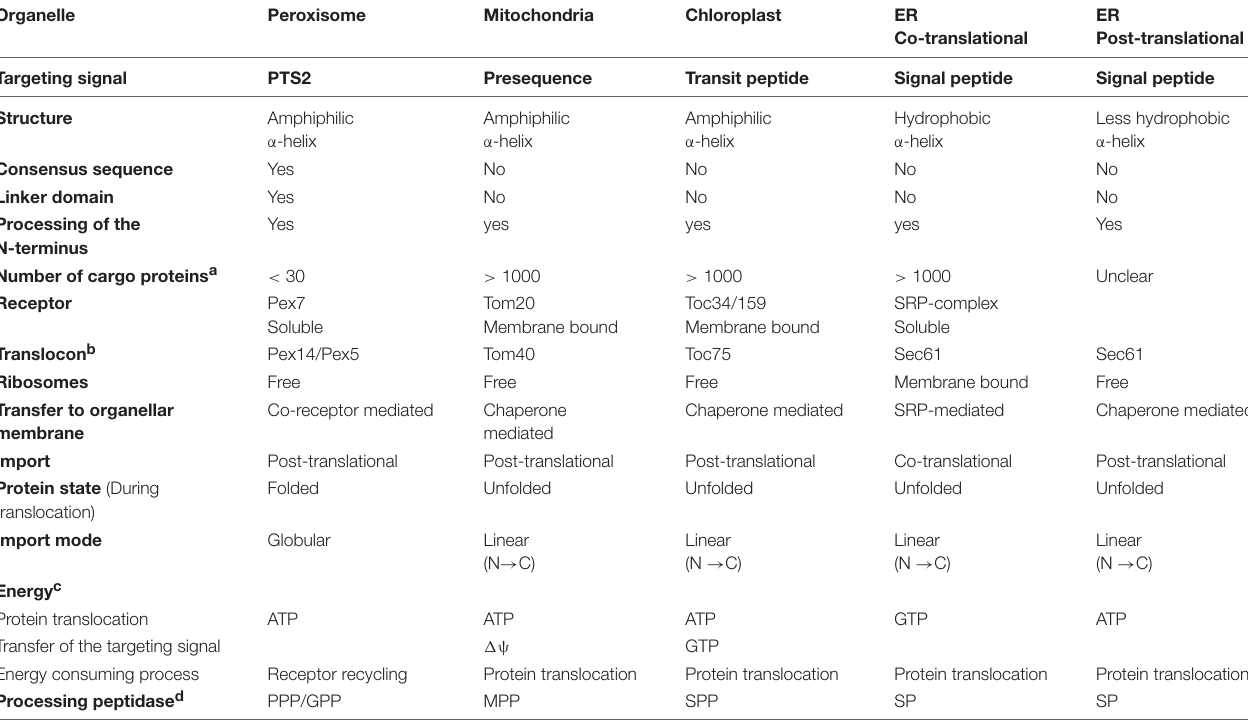
TABLE 1 | Transport processes mediated by the N-terminal targeting